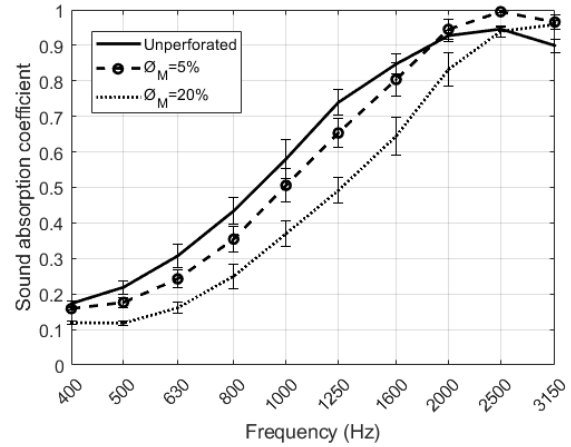
Figure 9. Results of the normal incidence sound absorption coefficient of the perforated RPU foam samples for D = 4 mm.